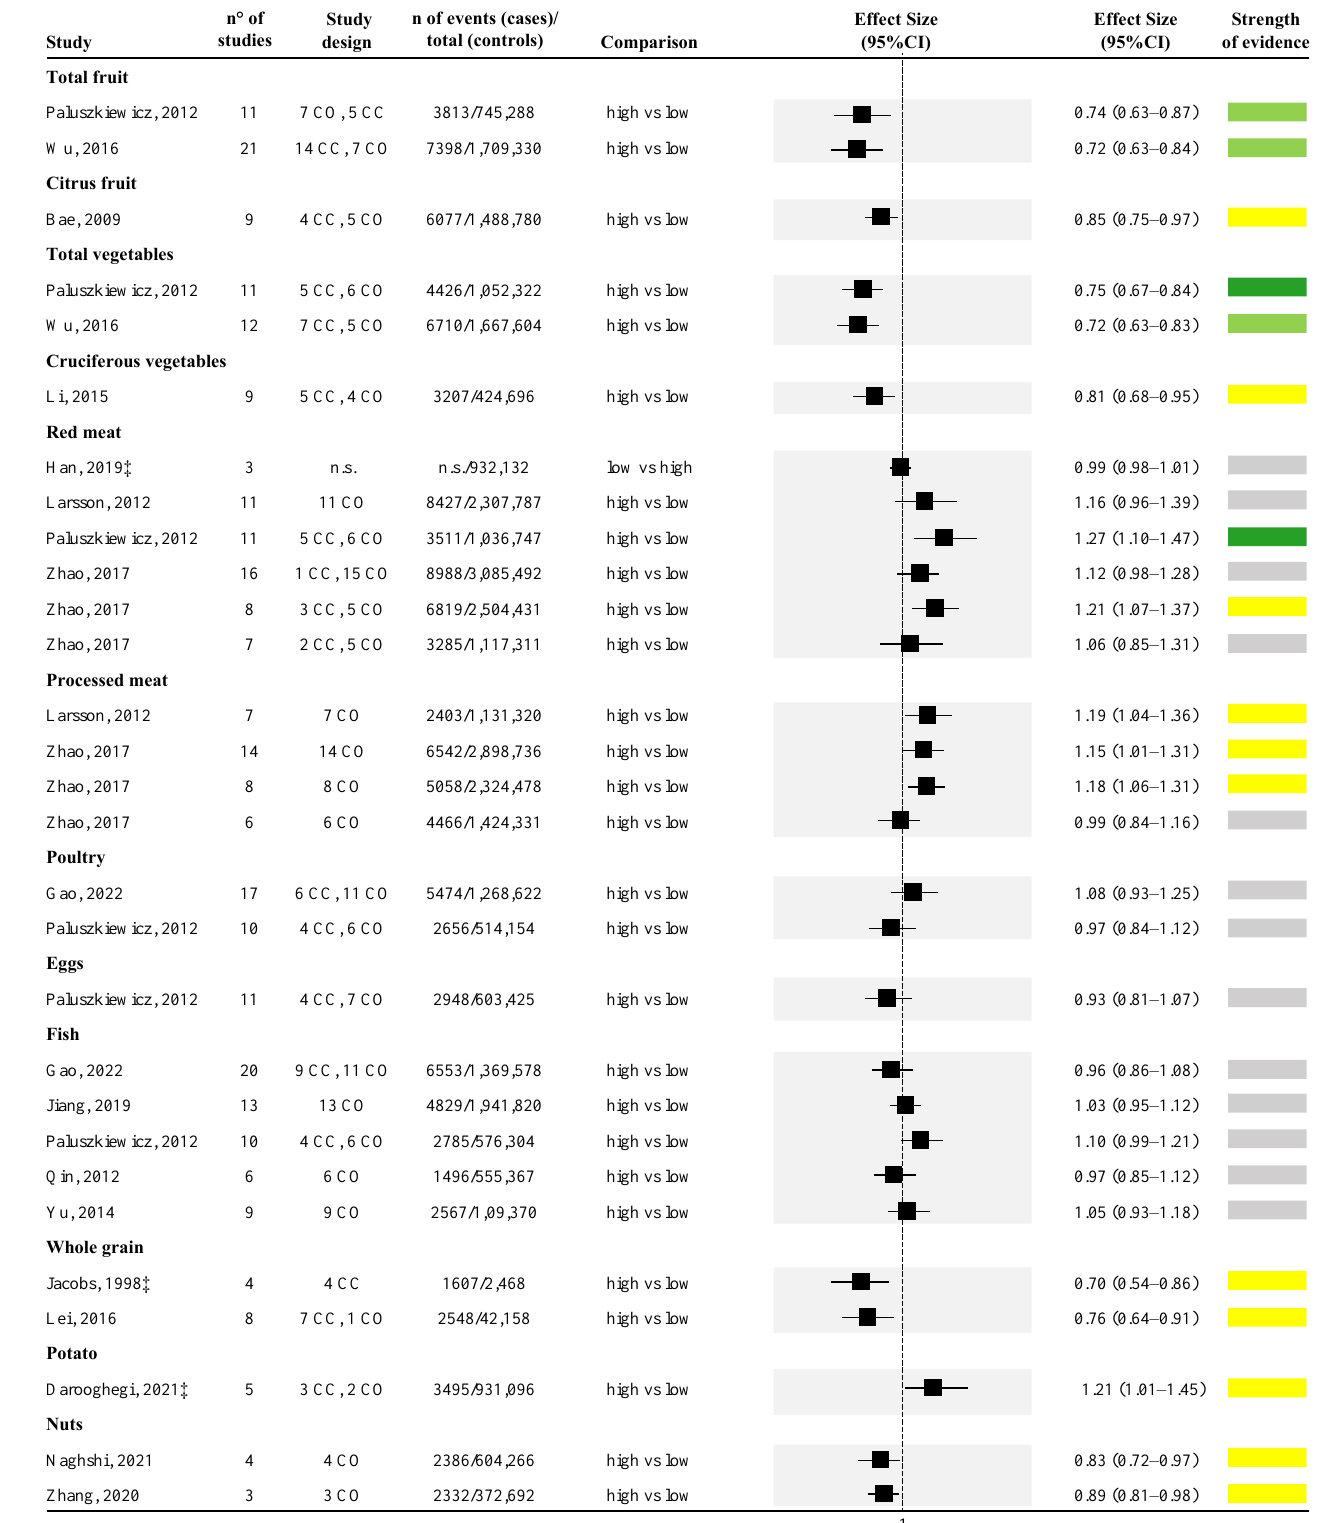
Figure 3. Forest plot of the meta-analyses assessing the association between dietary components and risk of pancreatic cancer